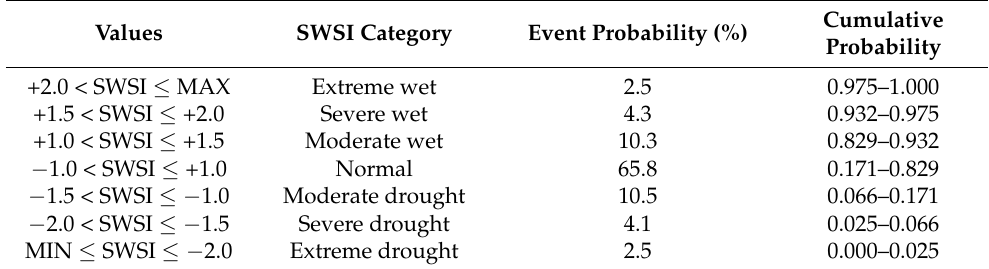
Table 5. SWSI Drought classes, value ranges, and the event probability.